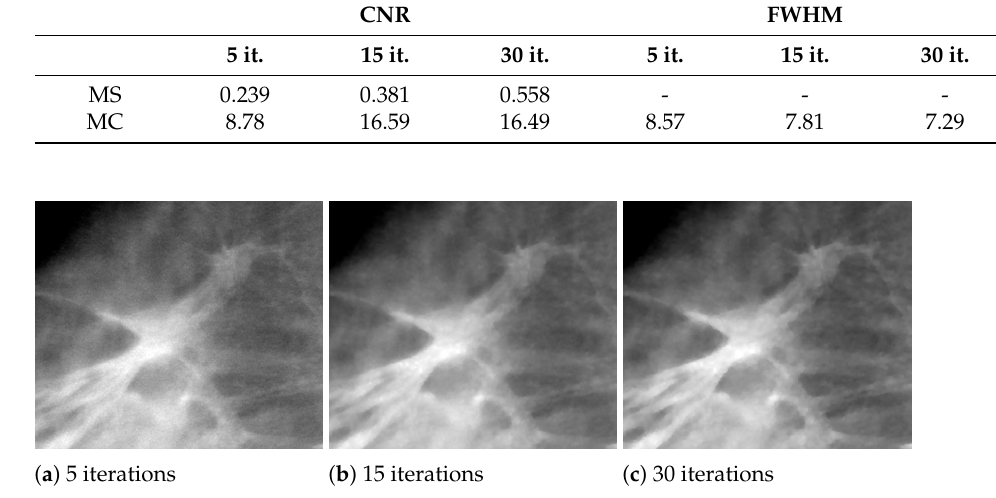
Figure 9. Results obtained after 5, 15 and 30 SGP iterations on a human breast data set. The reported 558 × 480 pixels crops present two speculated